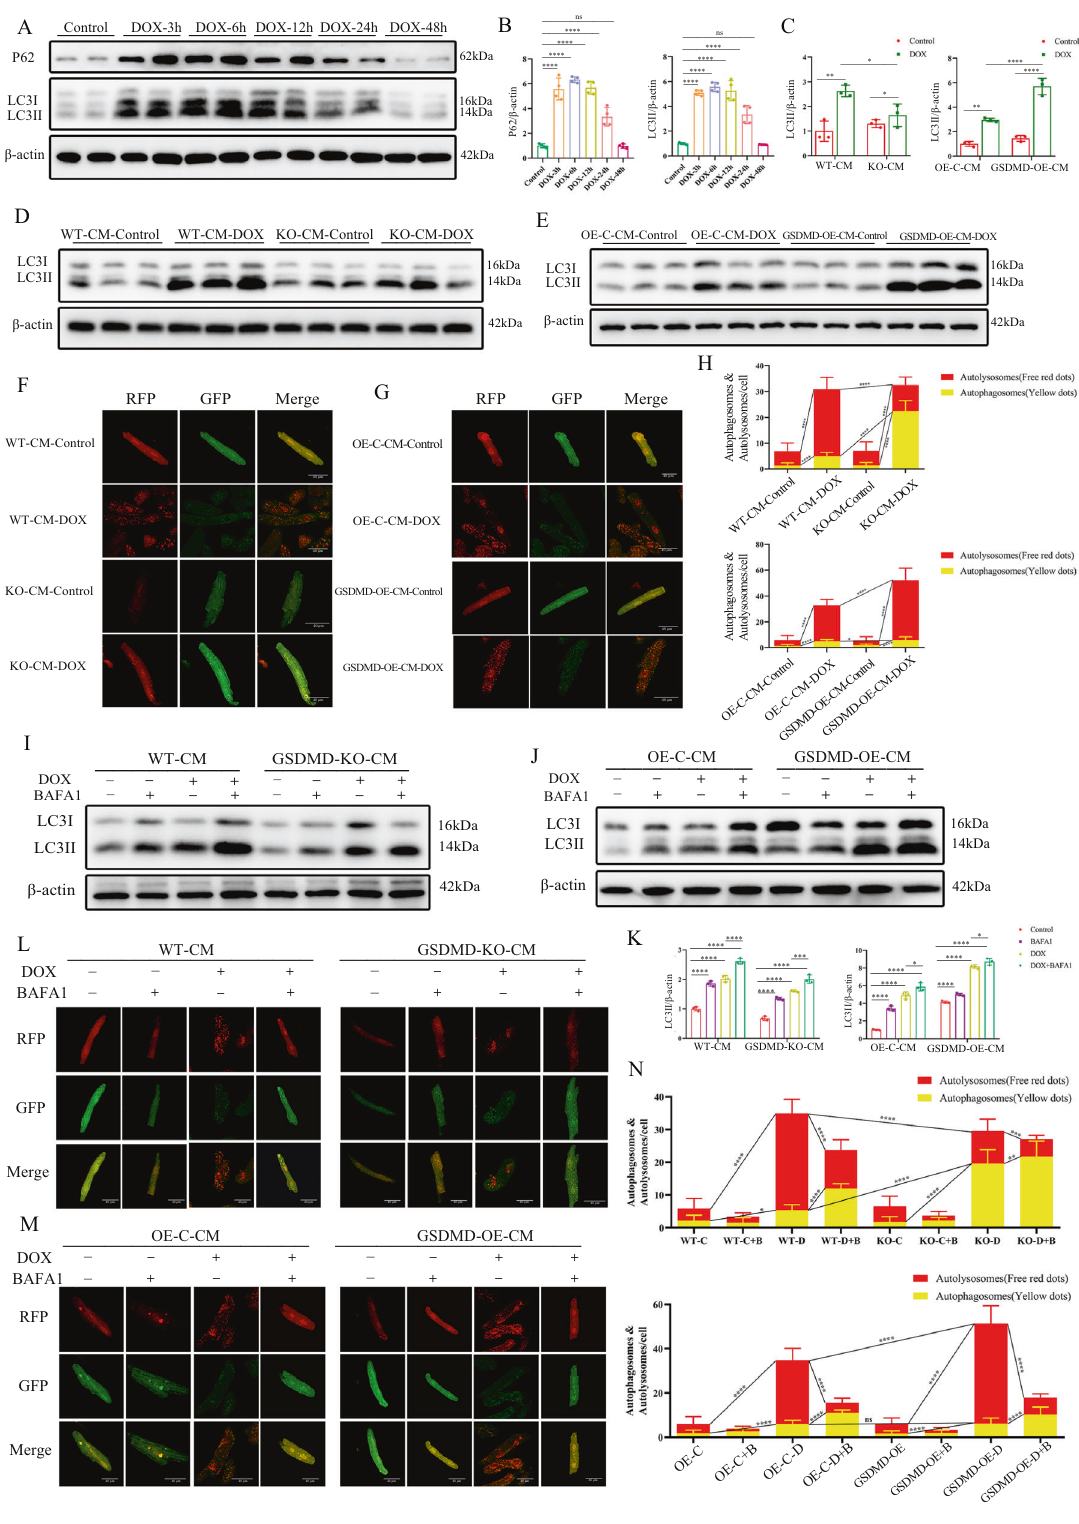
RNA-sequencing (RNA-seq) reveals potential target genes of GSDMD The above experiments suggested that GSDMD de fi ciency can play a protective role in the myocardium by inhibiting cardiac